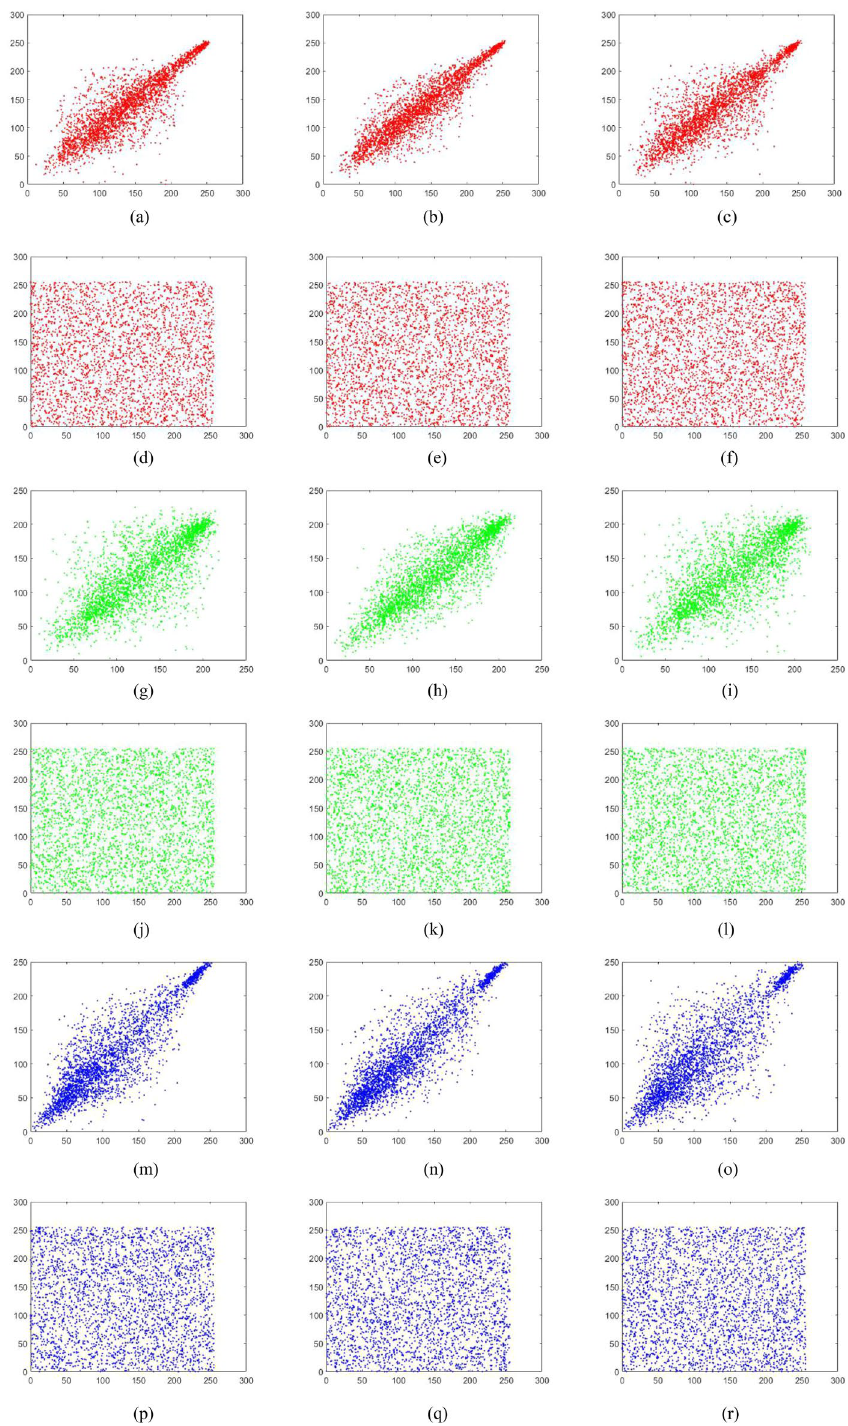
Figure 20. Distribution of adjacent pixels of the color image 4.2.03 and its encrypted image. ( a ) Horizontal direction of R channel of the color image 4.2.03, ( b ) vertical direction of R channel of the color image 4.2.03, ( c ) diagonal direction of R channel of the color image 4.2.03, ( d ) horizontal direction of R channel of encrypted color image 4.2.03, ( e ) vertical direction of R channel of encrypted color image 4.2.03, ( f ) diagonal direction of R channel of encrypted color image 4.2.03, ( g ) horizontal direction of G channel of the color image 4.2.03, ( h ) vertical direction of G channel of the color image 4.2.03, ( i ) diagonal direction of G channel of the color image 4.2.03, ( j ) horizontal direction of G channel of encrypted color image 4.2.03, ( k ) vertical direction of G channel of encrypted color image 4.2.03, ( l ) diagonal direction of G channel of encrypted color image 4.2.03, ( m ) horizontal direction of B channel of the color image 4.2.03, ( n ) vertical direction of B channel of the color image 4.2.03, ( o ) diagonal direction of B channel of the color image 4.2.03, ( p ) horizontal direction of B channel of encrypted color image 4.2.03, ( q ) vertical direction of B channel of encrypted color image 4.2.03, ( r ) diagonal direction of B channel of encrypted color image